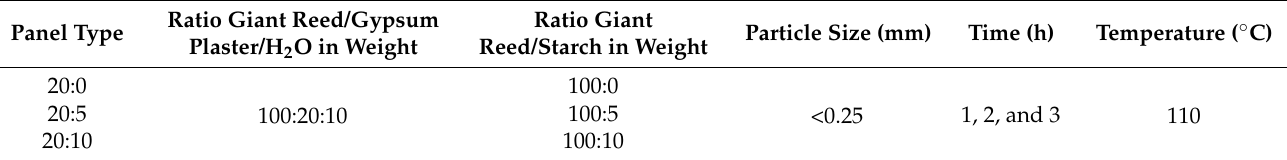
Table 1. Characteristics of the experimental